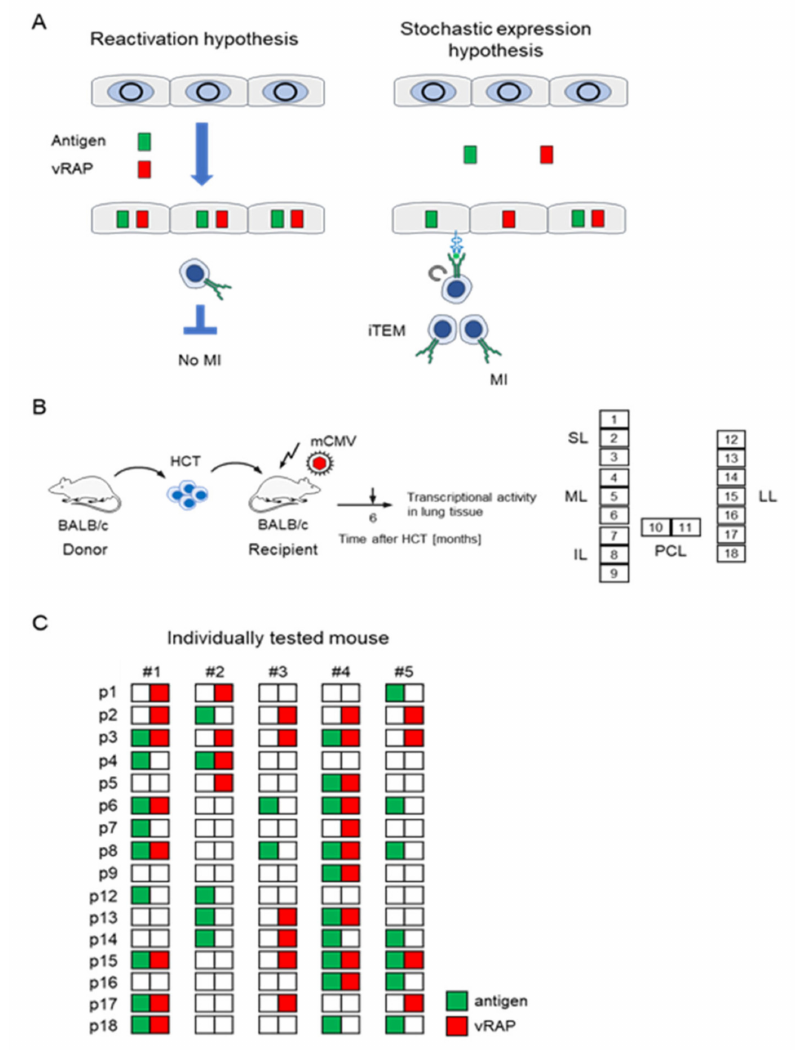
Figure 3. ( A ) Alternative models of viral gene expression during latency. (Circle) latent viral genome in the nucleus of a latently infected cell. (Antigen) IE1 and/or m164 peptide; (vRAP) m06 and/or m152; (MI) memory inflation; (iTEM) inflationary T effector-memory CD8 + T cell. ( B ) BALB/c ( H-2 d ) HCT model for establishing mCMV latency in the lungs. For the analysis of transcripts by RT-PCR, lungs are cut into 18 pieces, p1-p18; (SL, ML, IL) superior, middle, and inferior lobe of the right